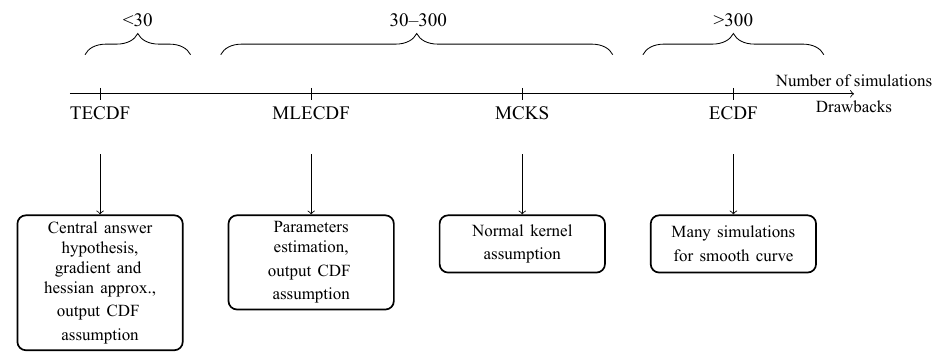
Figure 10. Advantages and drawbacks of each method to derive fragility curves.